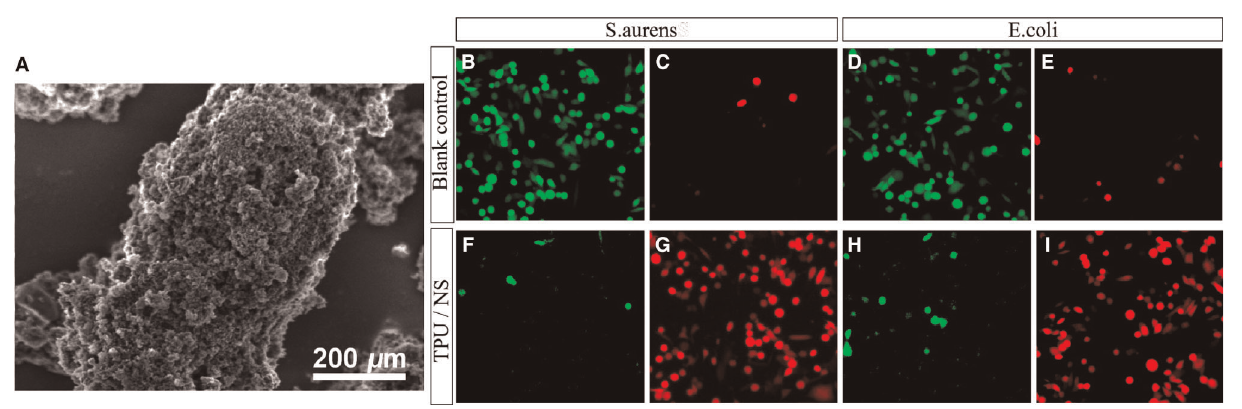
FIGURE 1 | Characterization and antibacterial properties of TPU/NS. ( A ) Scanning electron microscopy image of TPU/NS. ( B,C ) Viable and nonviable staining of cultured S. aureus ( B,C ) and E. coli ( D,E ) 12 h in the blank control group. ( F – I ) Viable and nonviable staining of cultured S. aureus ( F,G ) and E. coli ( H,I ) 12 h after adding TPU/NS